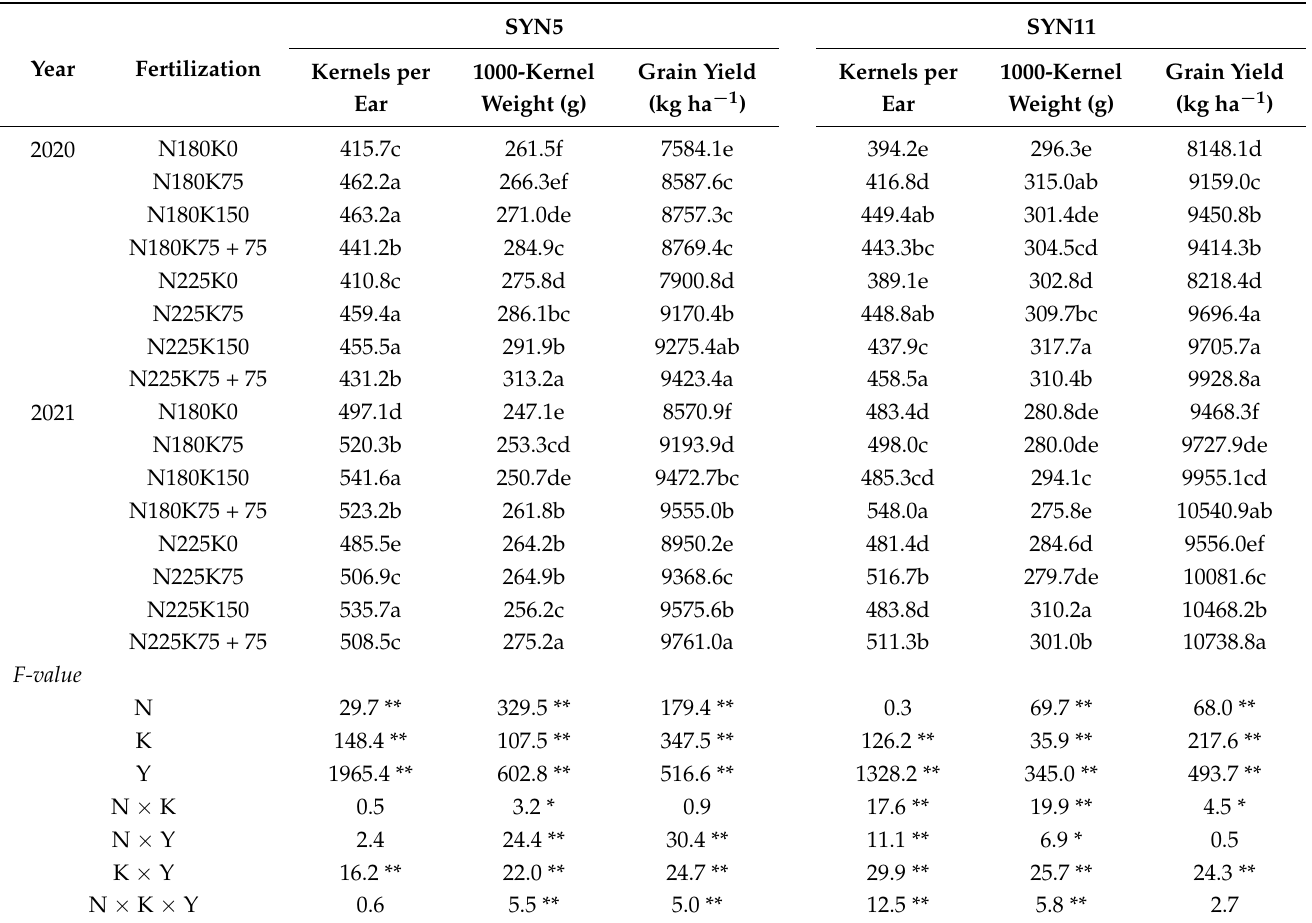
Table 1. Interactive effects of nitrogen and potassium on grain yield and yield components of waxy